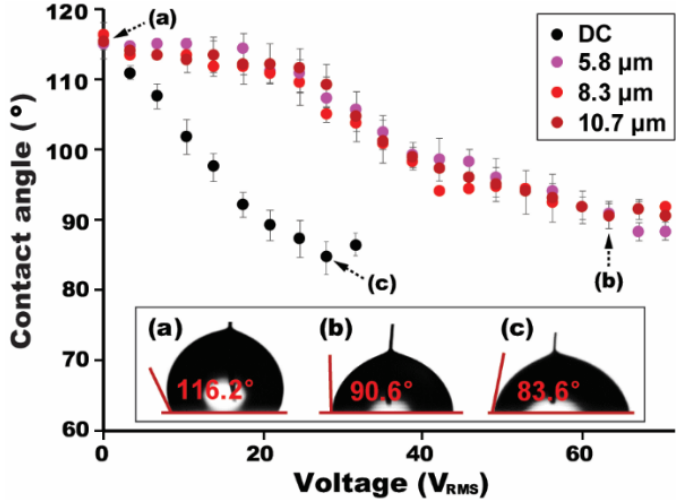
Figure 4. Thickness-independent contact angle modulation. Although the gel layer thickness was largely varied from 5.8 to 10.7 μ m, the variation in contact angles is nominal for different layer thicknesses. For the DC situation, such a decreasing trend in the contact angles is much steeper. An applied AC frequency was fixed at 5 kHz for all experiments.